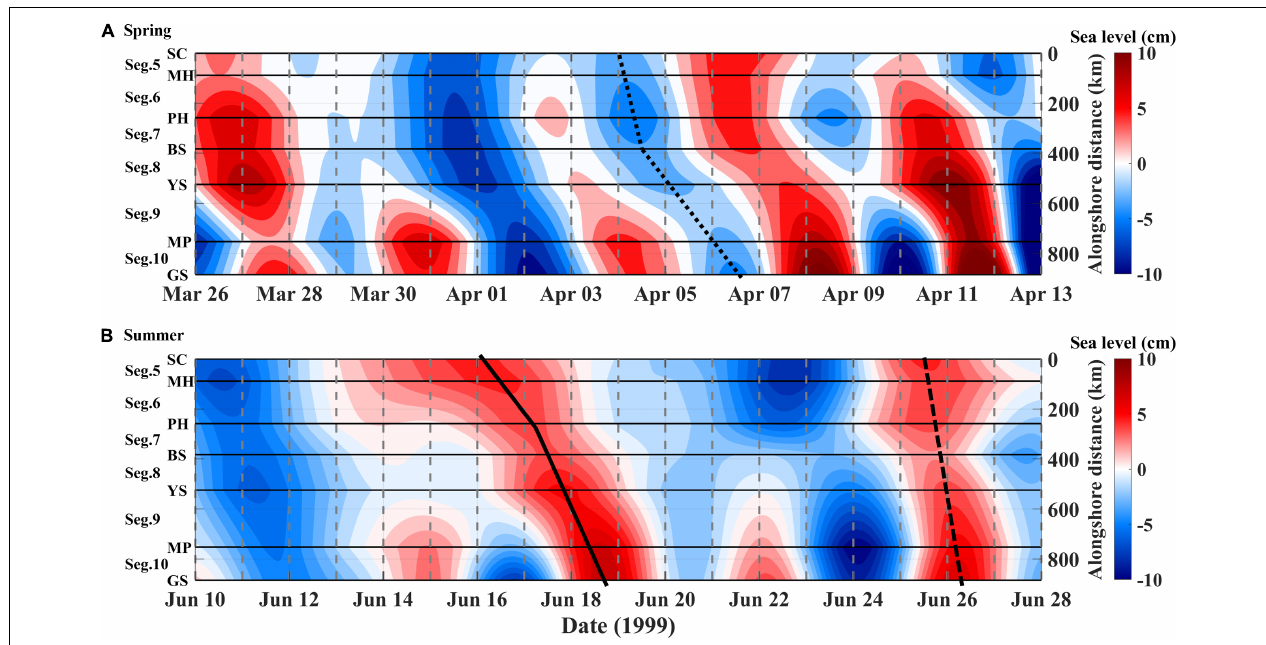
FIGURE 3 | Hovmöller diagrams ( x -axis: time, right y -axis: alongshore distance in km starting from SC to GS) for η adj (colors with color bar on the right) around the KP for (A) spring and (B) summer of 1999. The selected events along the peaked sea level marked by a black-dotted line in (A) and by a black solid and dashed lines in (B) highlight clockwise propagation of subtidal sea level fluctuations around the KP. Corresponding segments and TG stations are noted with labels on the left y -axis and horizontal lines.